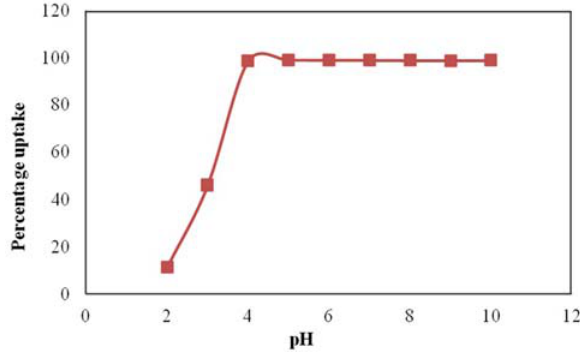
Figure 4. Effect of pH on the adsorption of MB by NTA-BP (Con- dition: 0.02 g of adsorbent in 20 mL of 100 mg/L dye solution at 150 rpm for 4 hours).